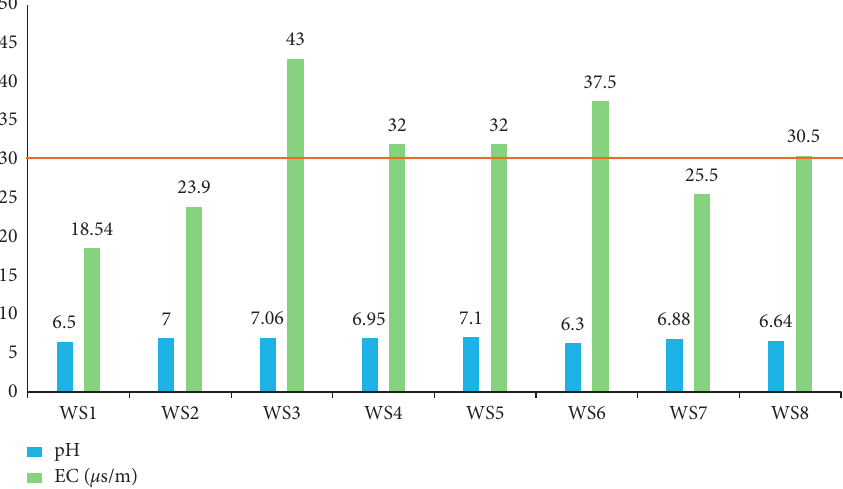
Figure 3: Physical characteristics (pH and EC) of the sampling waters.